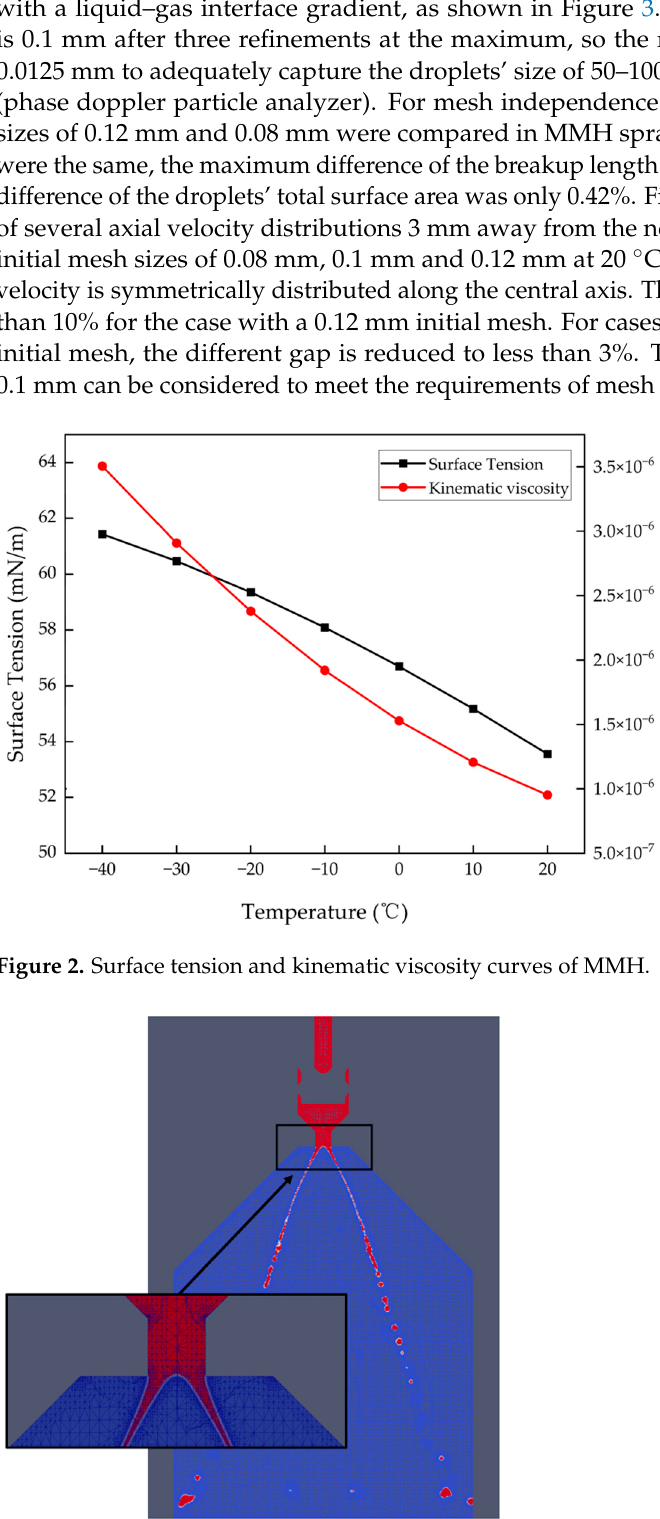
Figure 1. Physical model.